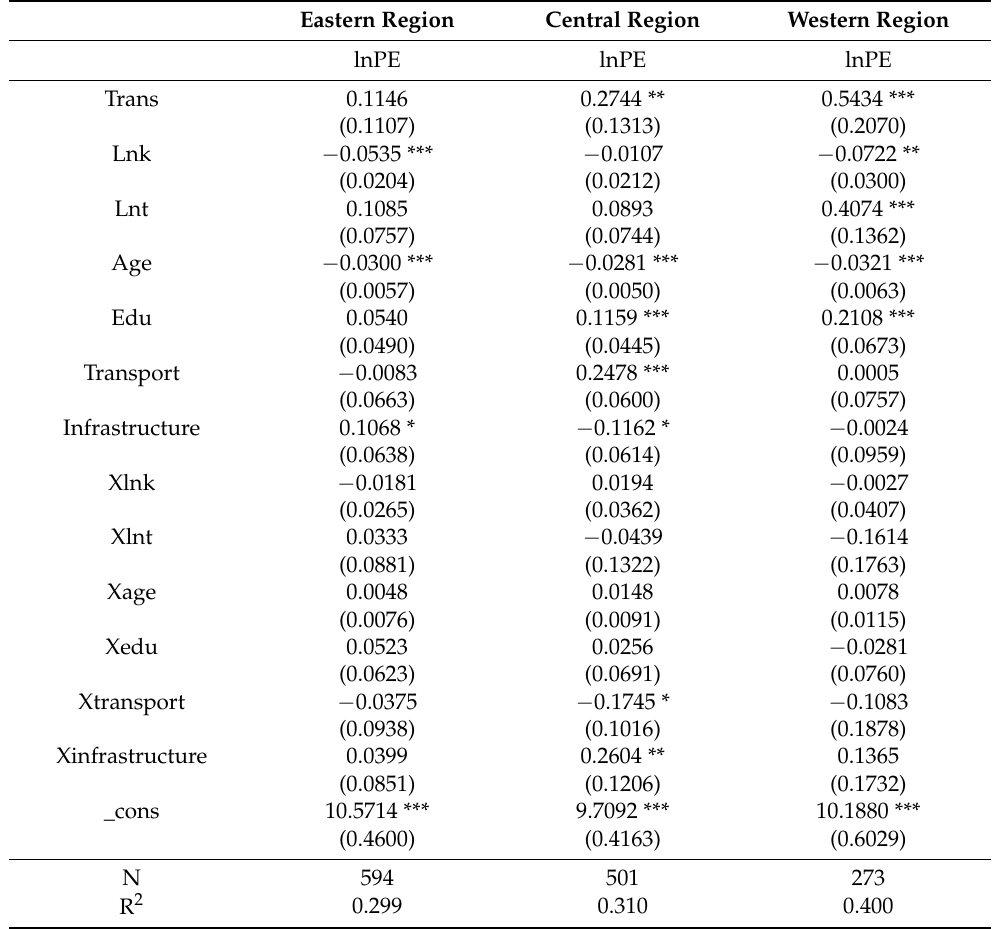
Table 7. Estimation Results for the ATE of Aggregate Labor Productivity in Different